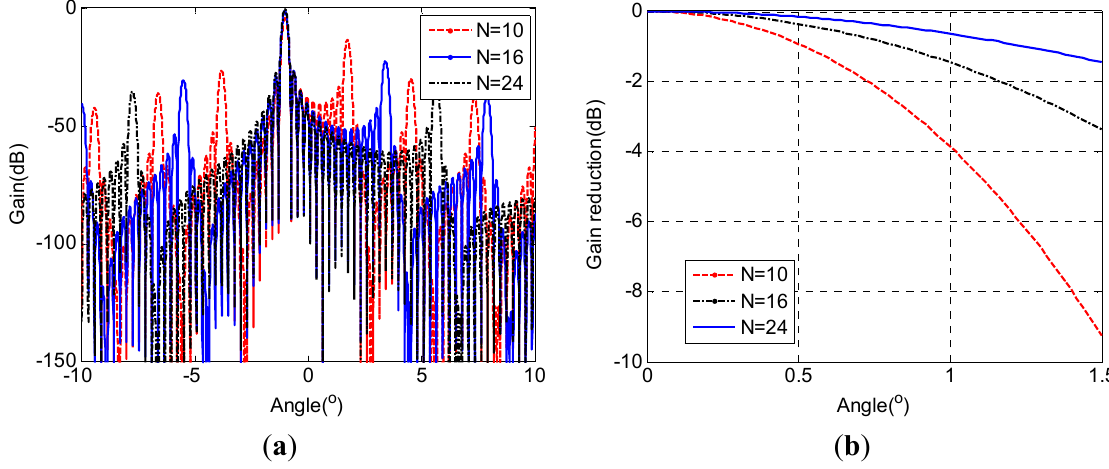
Figure 2. Antenna beam steering. ( a ) Grating lobes; ( b ) Main lobe